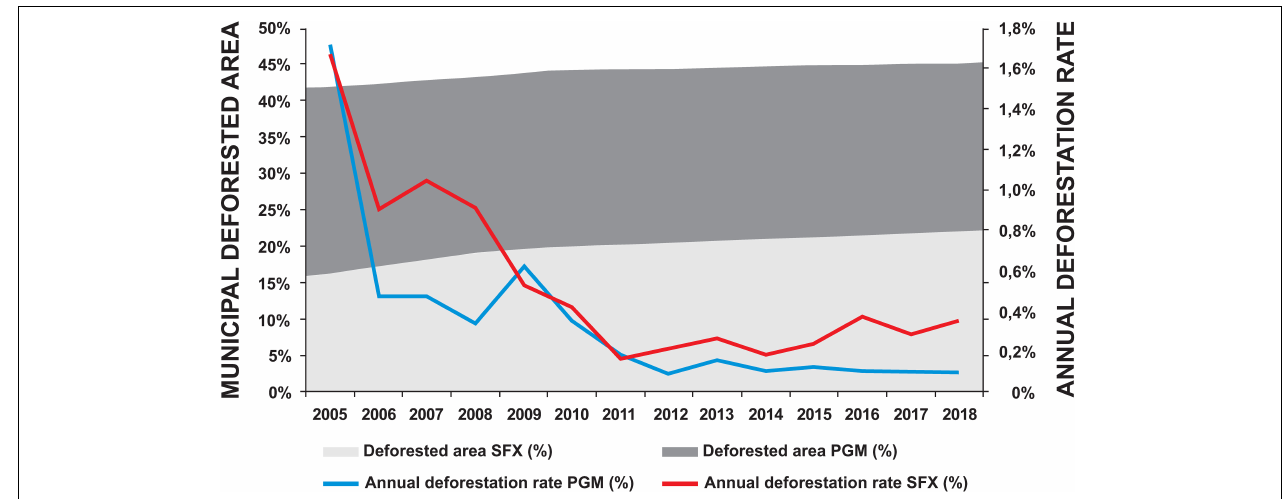
FIGURE 3 | Deforestation trends in SFX and PGM between 2005 and 2018. Source: INPE